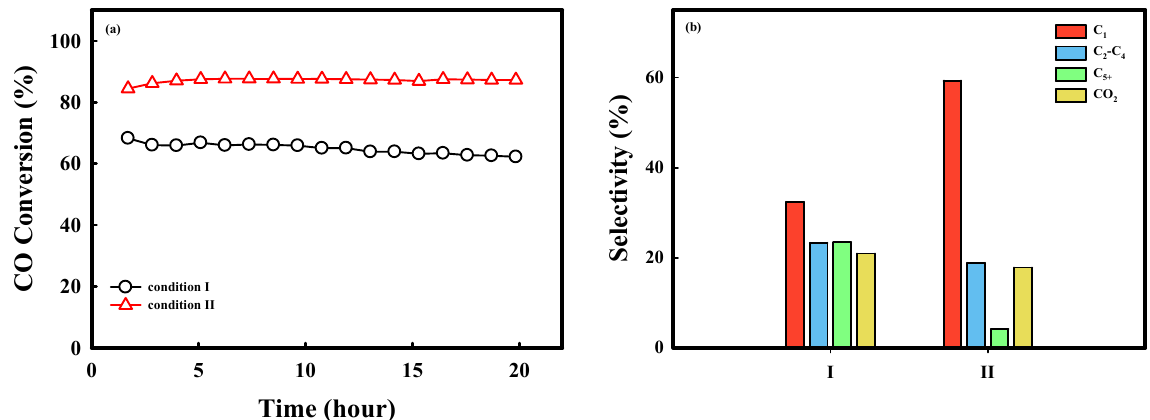
Figure 6. ( a ) The CO conversion with time on stream and ( b ) selectivity over the 40CFAl_P catalyst, under two different conditions ((I) 6000 mL/g/h, 300 °C; and 10 bar; (II) 4000 mL/g/h, 350 °C, and 20 bar).